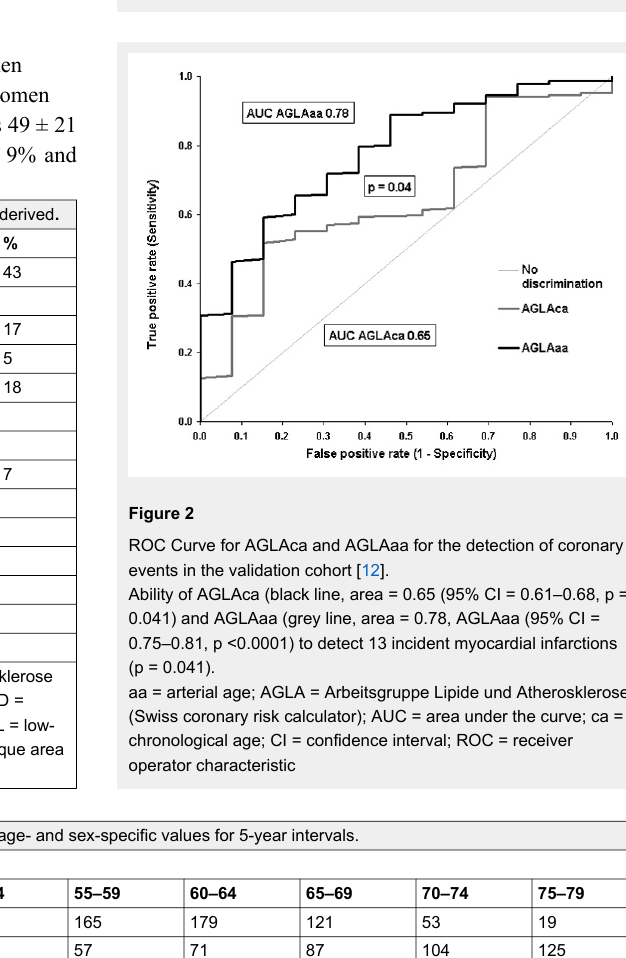
Figure 1 Distribution of mean (± standard deviation) TPA values by age group in 851 men and 636 women. Exponential curve of total plaque area (TPA) for 851 male and 636 female patients aged between 35 and 79 years. The formulae shown above the male curve in red and below the female curve in blue form the basis of the arterial age calculations.